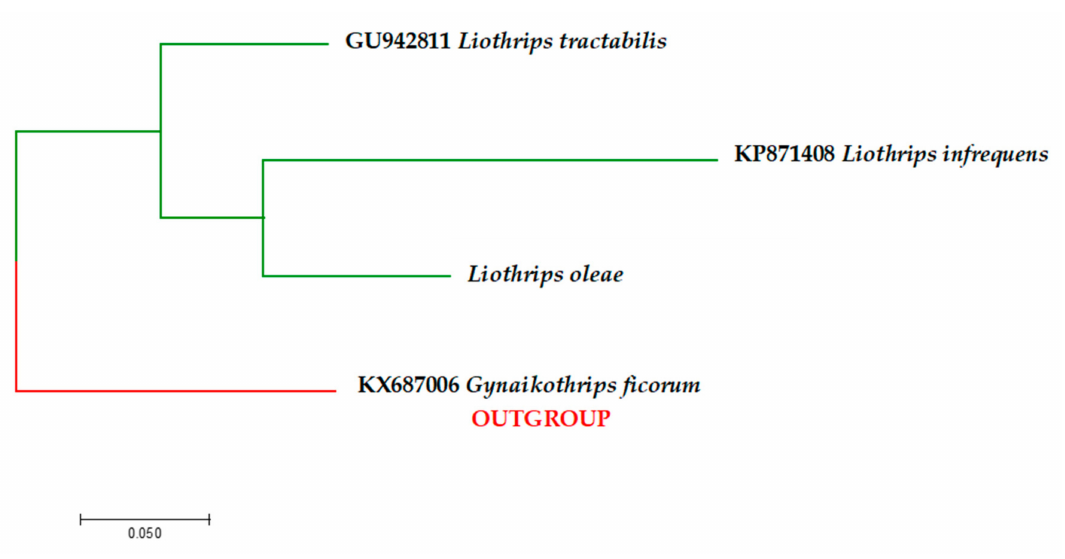
Figure 3. Bootstrap consensus tree generated using the maximum likelihood (ML) method and general time reversible (GTR) G + I (gamma + invariant) model showing the genetic di ff erences and relationship between Liothrips oleae obtained by mt- COI sequences and all other Liothrips species available in GenBank. Gynaikothrips ficorum was used as an outgroup. Species name and GenBank accession number are shown in the